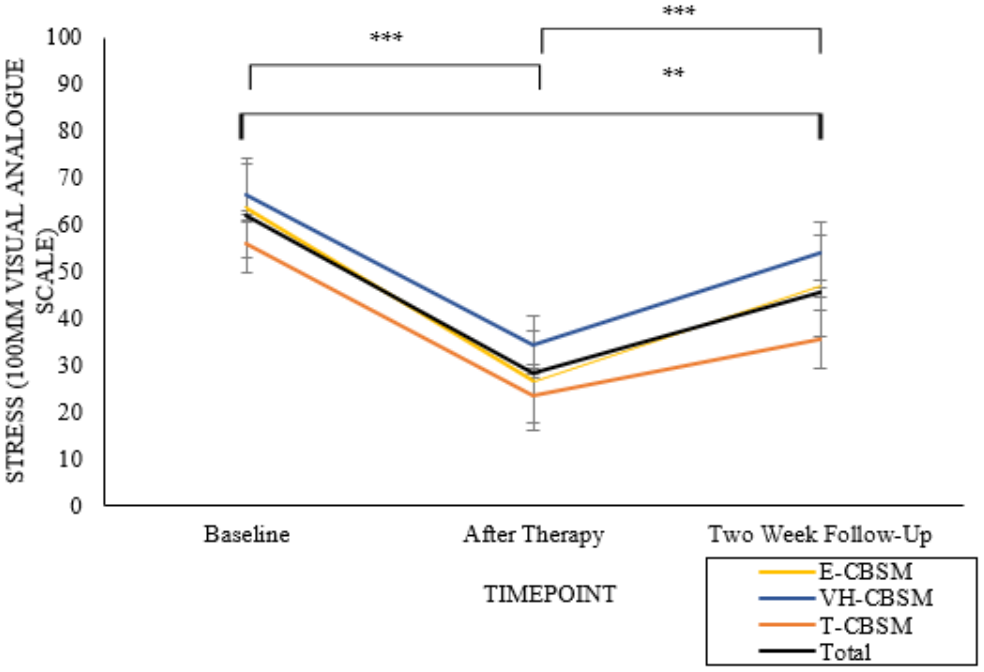
Figure 2. Significant improvements in state stress from baseline to after the therapy session and at two weeks follow-up. Note, mean scores and standard error bars are de- picted (*** p < 0.001, ** p < 0.01).